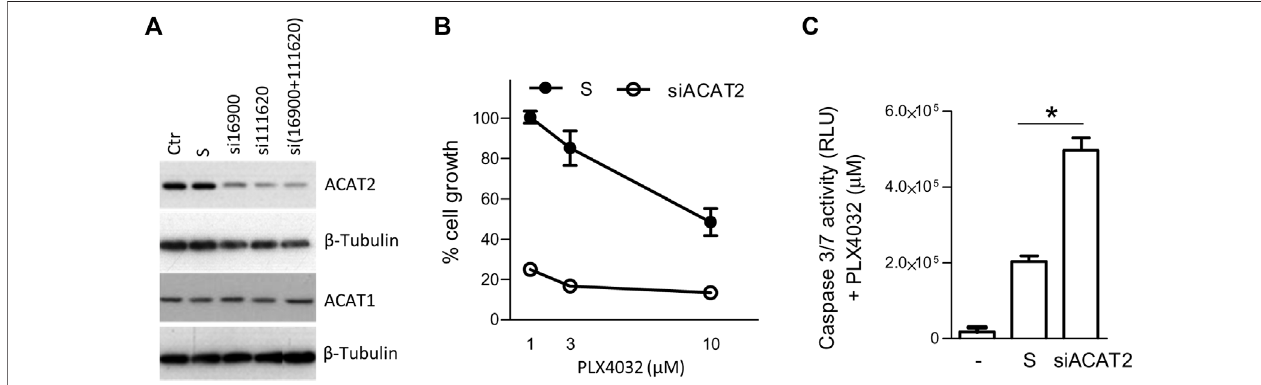
FIGURE5| ACAT2downregulationimpairsBRAFiresistanceinmelanomacelllines. (A) .LM16RcellsweretransfectedwithtwoACAT2-directedsiRNAs(si16900 andsi111620)orwiththeirmixtureinstandardcultureconditions.TheexpressionlevelsofACAT2andACAT1wereevaluatedbywesternblotting72 haftertransfection. β -tubulinwasusedasloadingcontrol. (B) .EffectsofACAT2siRNAmixture(72 h)onPLX4032sensitivitydeterminedbyCCK8assay. (C) .EffectsofACAT2siRNA(72 h) onPLX4032(10 µM)sensitivity bycaspase3/7activationassay.-:untreated control;S:scrambledcontrol;siACAT2:ACAT2siRNA mixture.* p < 0.05byone-way ANOVA followed by Bonferroni correction. The experiment was repeated three